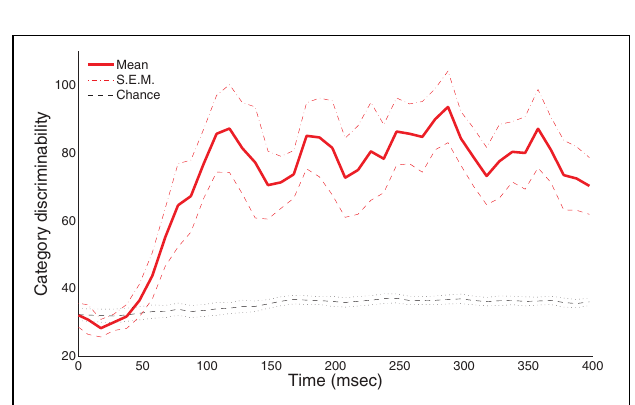
FIGURE 3 | Category-discriminative time course in MEG magnetometers. Group-level category-discriminabilitive time course (visual stimulus onset at 0ms) compared against pooled chance-level time course computed from trials with shuffled category